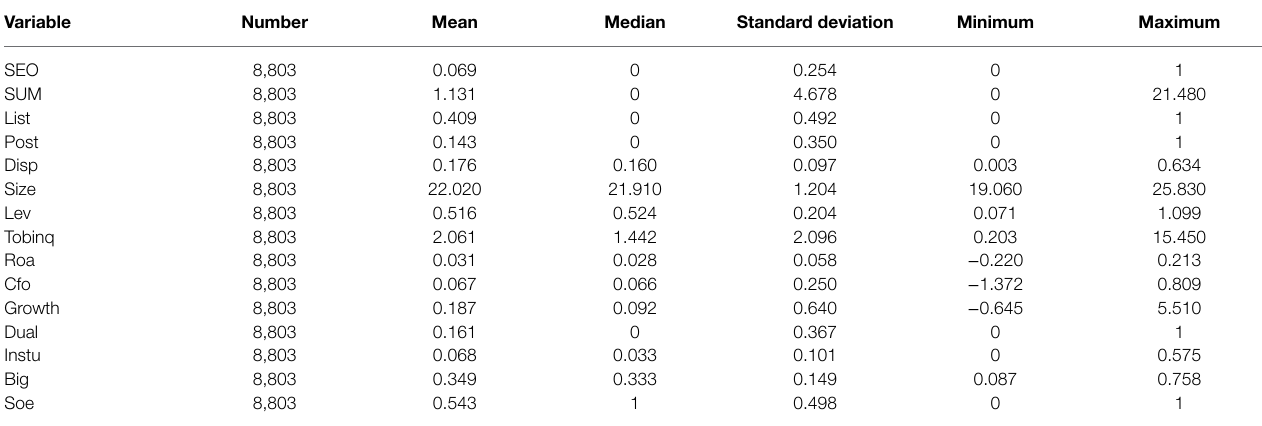
TABLE 2 | Variable descriptive statistics.